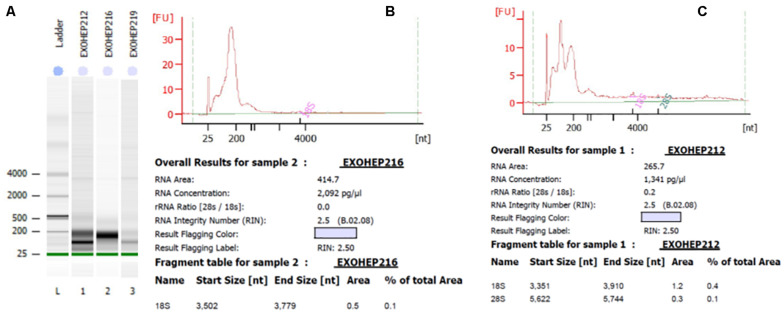
Bioanalyzer analysis of total exosomal RNA by Agilent RNA Pico Chip. The RNA 6000 ladder standard (A) first lane contains five RNA fragments between 0.2 and 6 kB. In bands of exosomal RNA from plasma, almost all of the samples revealed a visible band in the small RNA area. (B,C) Elecrophoregram for total exosomal RNA.